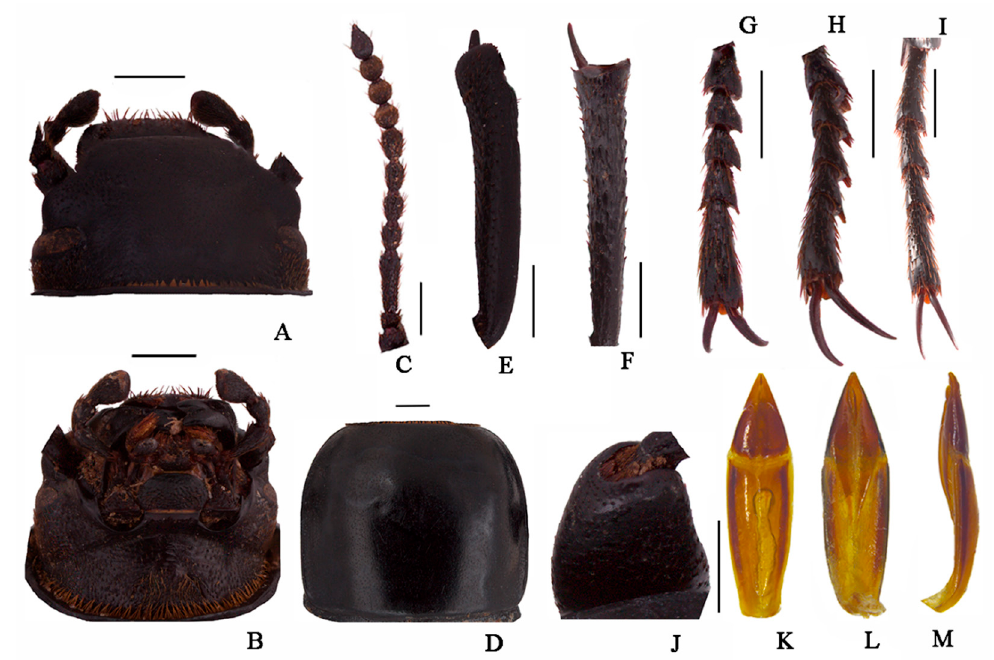
Figure 3. Nalepa quadrata Li & Ren, sp. n. ( A ) head, dorsal view; ( B ) head, ventral view; ( C ) antenna; ( D ) pronotum; ( E ) protibia; ( F ) mesotibia; ( G ) protarsus; ( H ) mesotarsus; ( I ) metatarsus; ( J ) profemora; ( K – M ) aedeagus: ( K ) dorsal view; ( L ) ventral view; ( M ) lateral view. Scale bars: ( A – J ) (1.0 mm), ( K – M ) (1.0 mm).